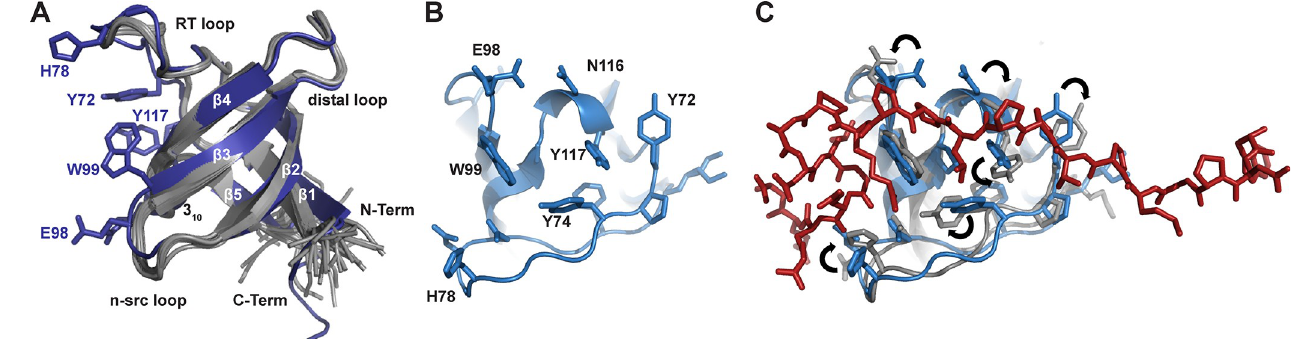
Fig 2. Comparison of the Lyn SH3 structures. A. Overlay of the X-ray structure with the NMR structure. The Lyn SH3 crystal structure is colored in blue and the NMR structures in grey. The RMSD value is 0.93 Å for all C α atoms. B. Comparison of the crystal structure of the unliganded Lyn SH3 domain with the NMR structure with peptide bound. Top view of the polyproline binding pocket of the X-ray crystal structure of the Lyn SH3 domain. The highlighted residues are in different conformations than observed in the peptide-bound NMR structure. C. Overlay of the unliganded X-ray crystal structure of unliganded SH3 domain (blue) with peptide-bound NMR structure (grey). The peptide is shown in red. Side chain rotations are indicated by arrows.